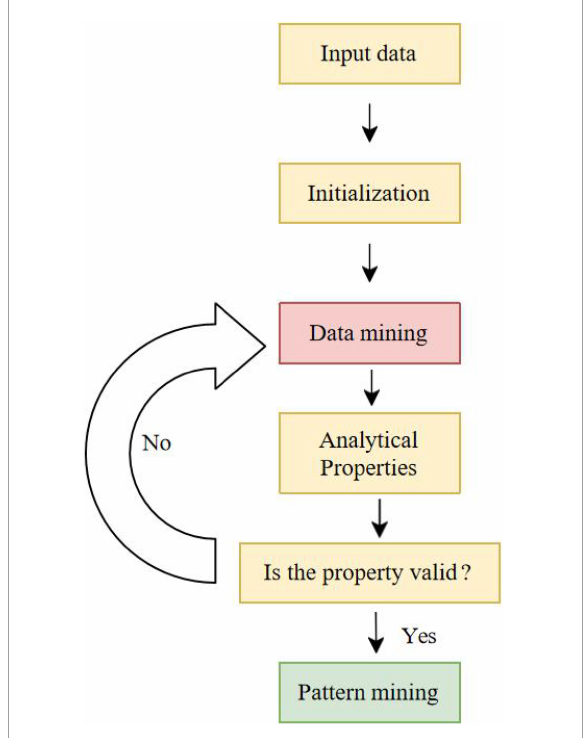
FIGURE2 Flow chart of algorithm